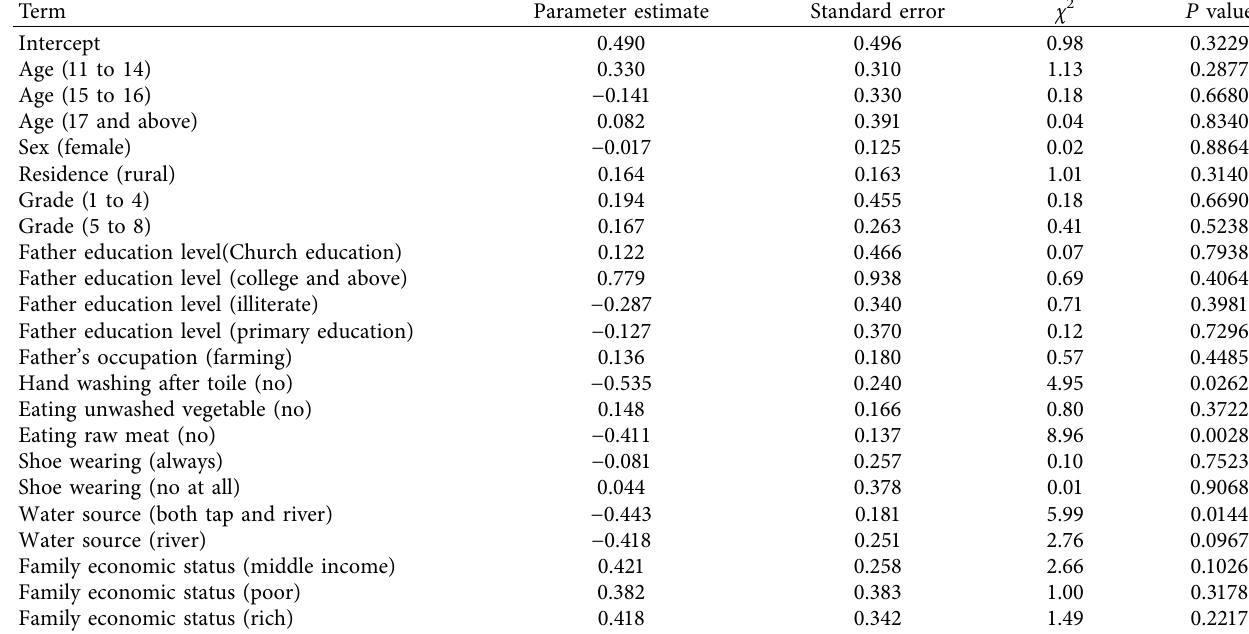
Table 4: Relationship between explanatory variables and Entamoeba histolytica/dispar infection among school children in Jaragedo town, South Gondar Zone,